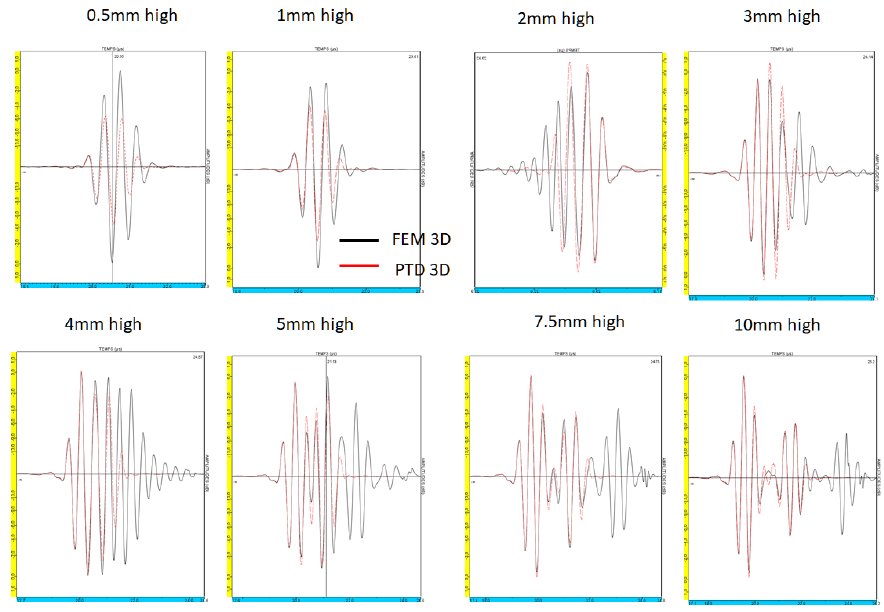
Figure 5. Inspection of a 25 mm extent rectangular crack of varied height inspected using P60 waves in TOFD mode at 2.25 MHz: Ascan versus the flaw height.